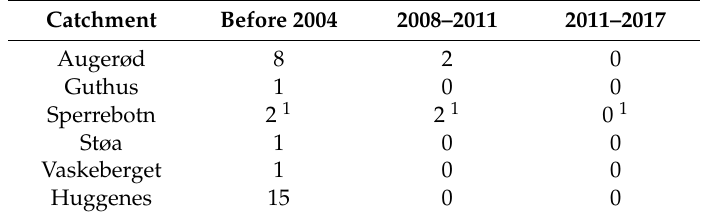
Table 5. Number of sewage systems form single households with direct